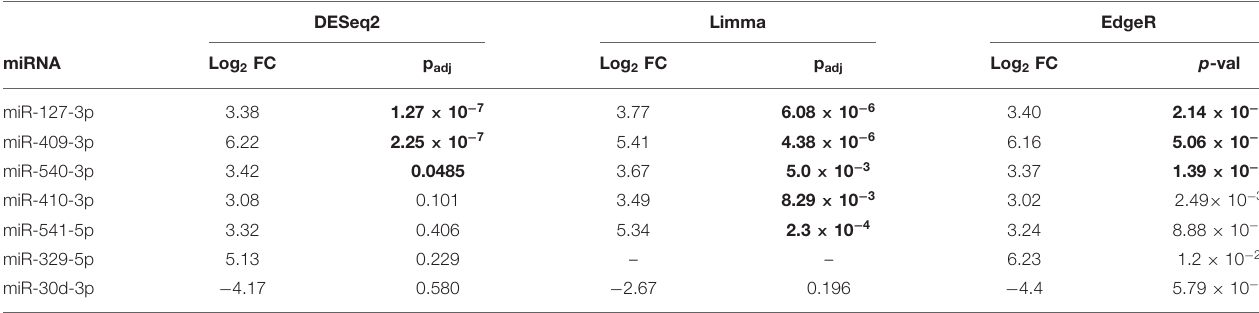
TABLE 1 | Summary of the 7 most differentially-expressed miRNAs detected in serum UC exosomes from 14-week male BALB/c and NOD mice using three statistical packages in RStudio. DESeq2 Limma EdgeR